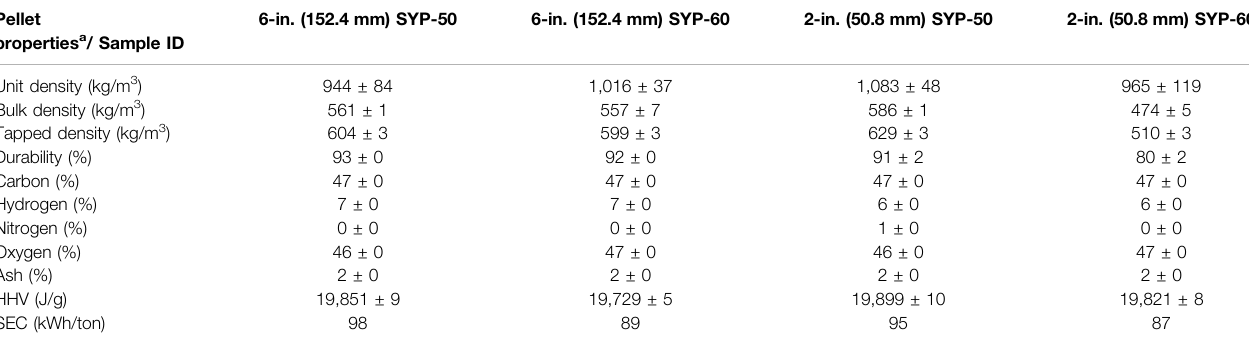
TABLE 5 | Average physico-chemical properties of switchgrass (SG) and southern yellow pine (SYP) blended pellets immediately after pelleting produced during 2.5-ton demonstration. Pellet properties a / Sample ID